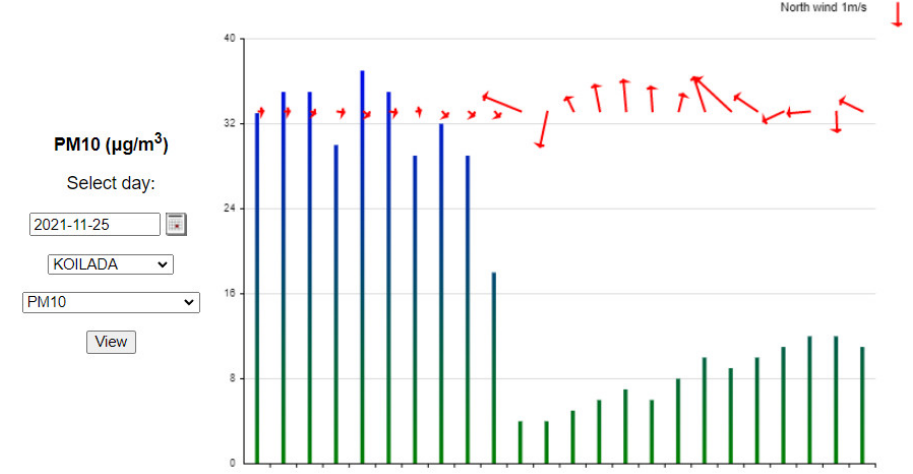
Figure 6. Pollutant with wind data diagram.